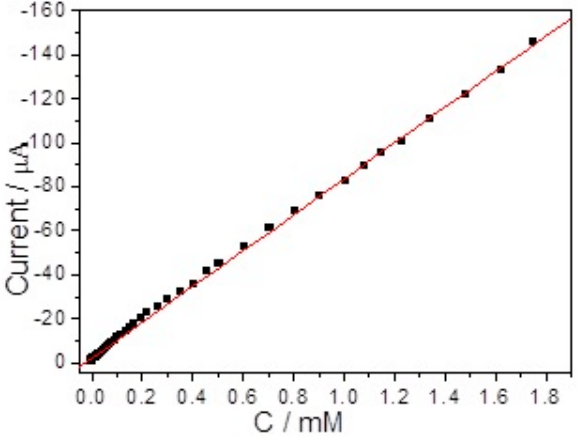
Figure 7. The calibration curve of the amperometric response.